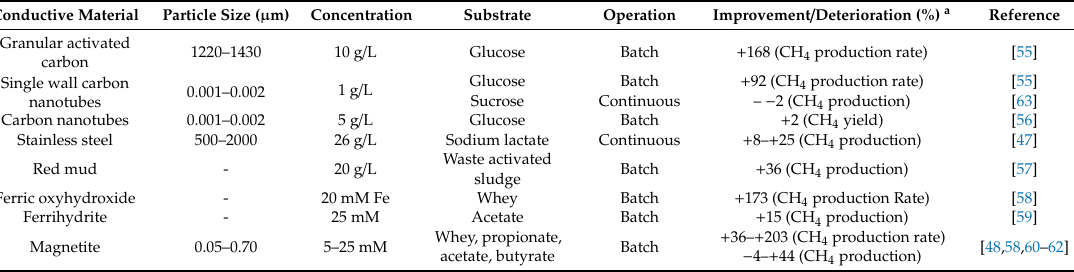
Table 2. Impact of various conductive material (CM) supplementation upon CH 4 productivity. Conductive Material Particle Size ( µ m)